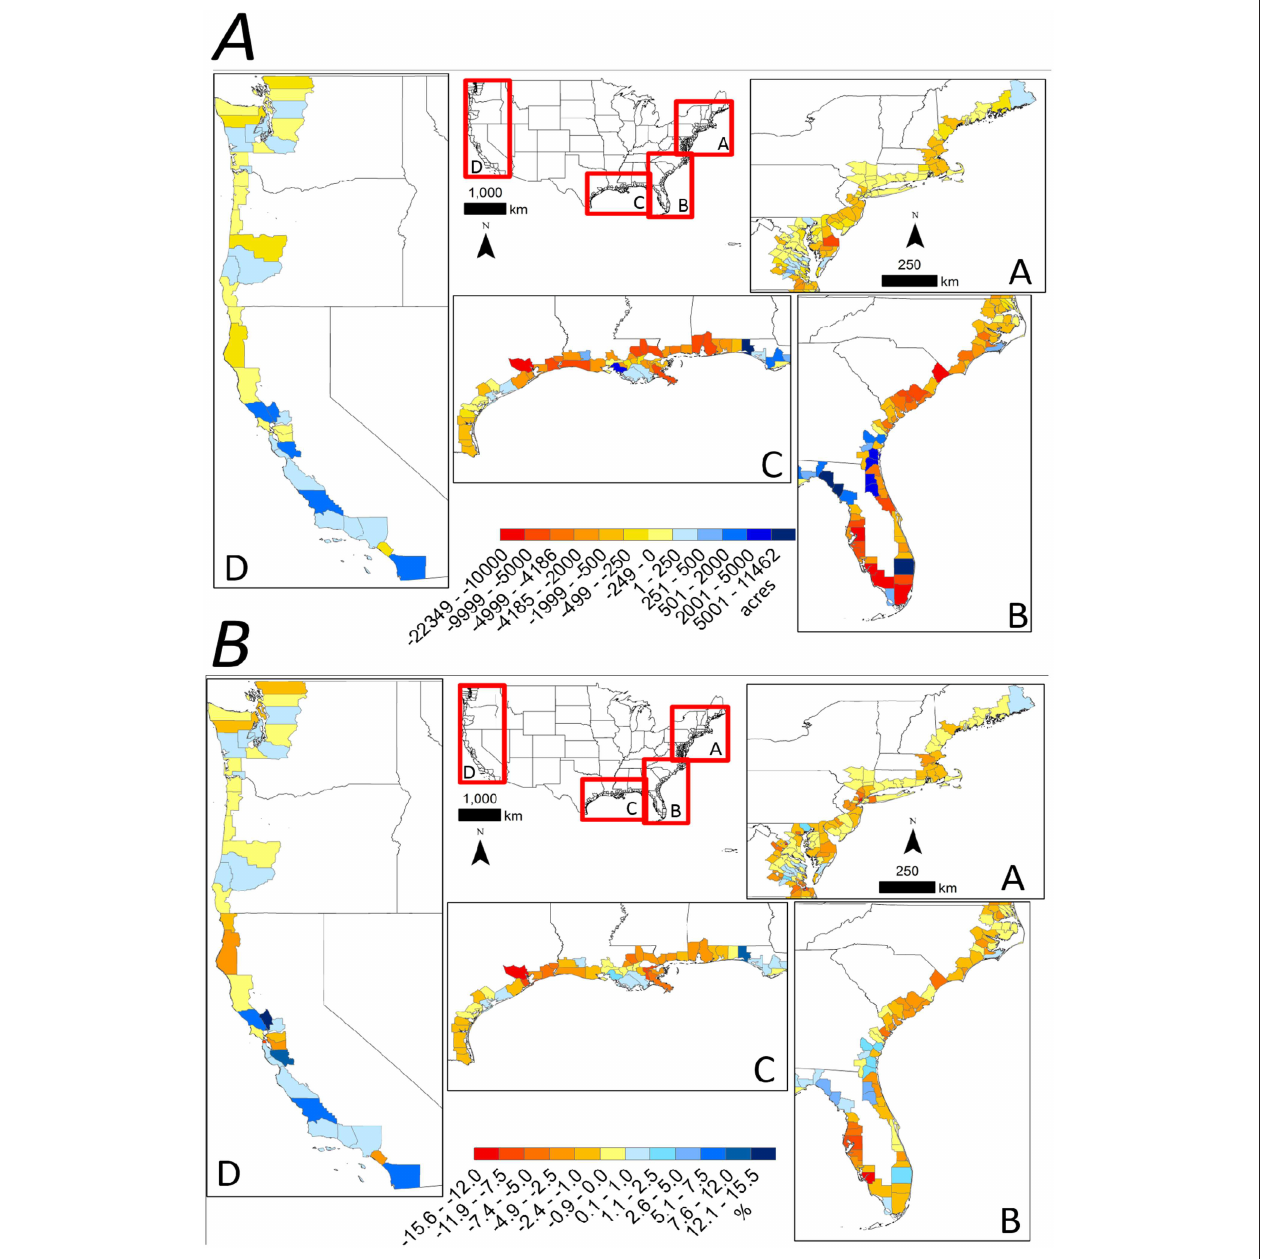
FIGURE 3 | National maps with inset panels showing coastal county-level variation in the (A) cumulative raw acreage change in palustrine wetlands from 1996 to 2010 and (B) cumulative percent change in palustrine wetlands acreage from 1996 to 2010 in the (A) Northeastern coastline, (B) Southeastern coastline and gulf coast of Florida, (C) Gulf of Mexico coastline, and (D) Pacific coastline of the conterminous United